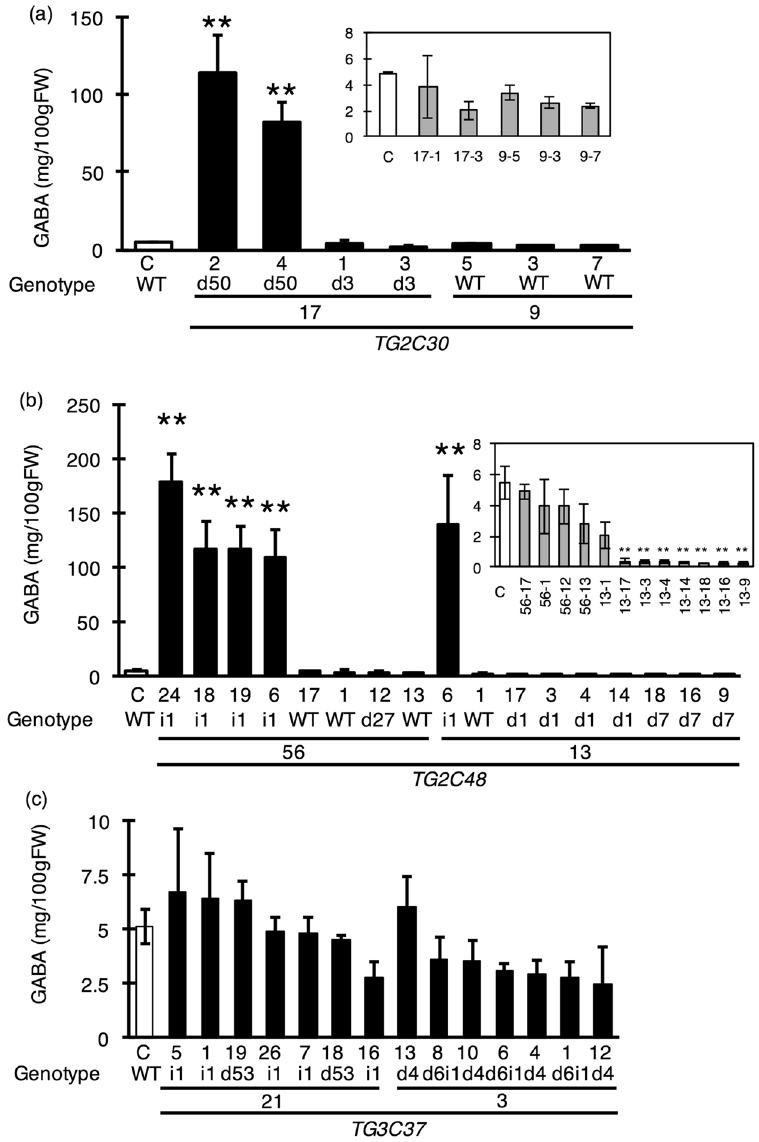
Figure 4. Leaf GABA content in the T 1 generation. GABA content of leaves was measured by HPLC. All lines were homozygous. Bars indicate standard deviation (n = 3) and asterisks indicate statistical differences in relation to control according to the Tukey-Kramer’s test ( * P < 0.05 and ** P < 0.01). ‘C’ is the control plant with WT genotype. ( a , b and c ) show GABA content in TG2C30, TG2C48, and TG3C37 mutated lines,